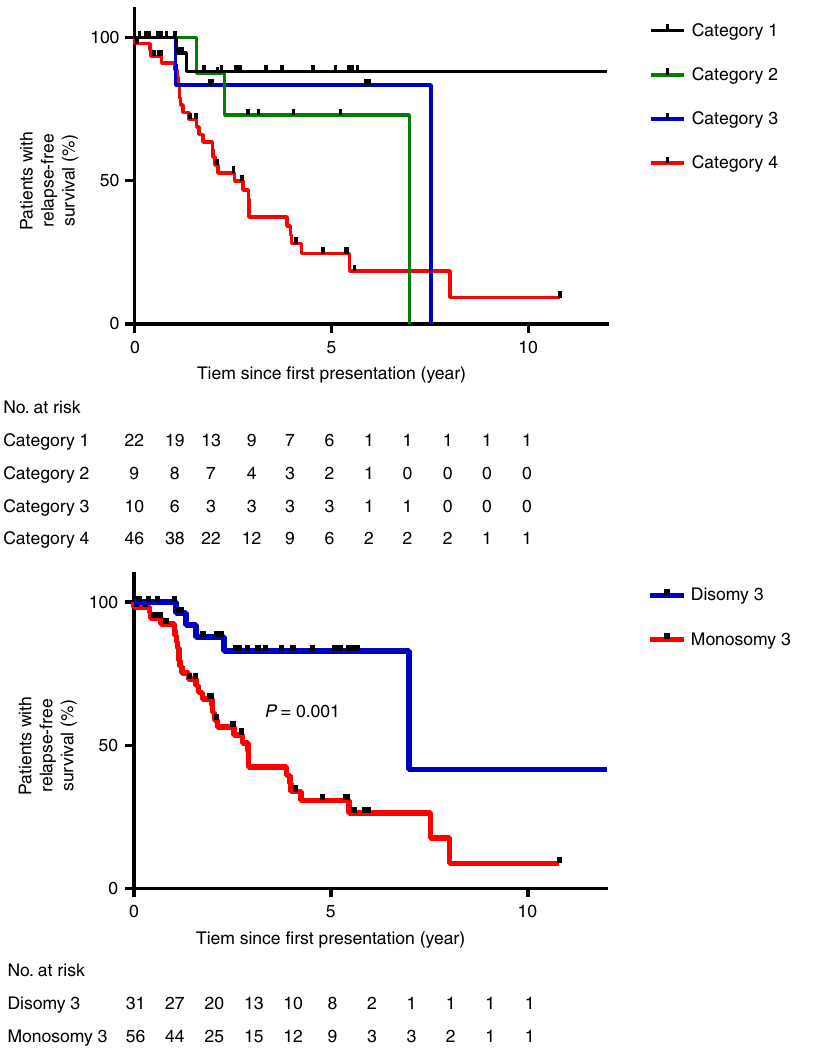
Fig. 4 Kaplan – Meier estimates of relapse-free survival (RFS) for UM patients. Higher risk categories have shorter RFS. UM patients with monosomy of chromosome 3 has signi fi cantly shorter RFS than patients with disomy 3 (blue). Difference between curves were assessed using a two-sided log-rank (Mantel-Cox) test; p -values were not adjusted for multiple